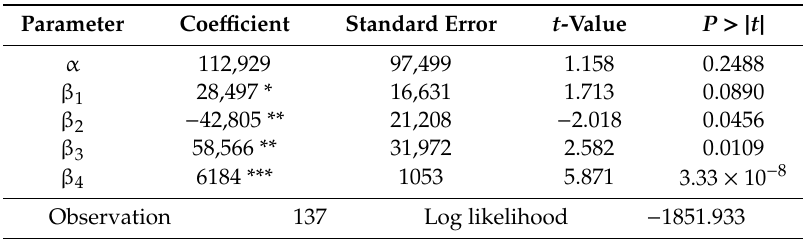
Table 5. Estimation results from hedonic pricing